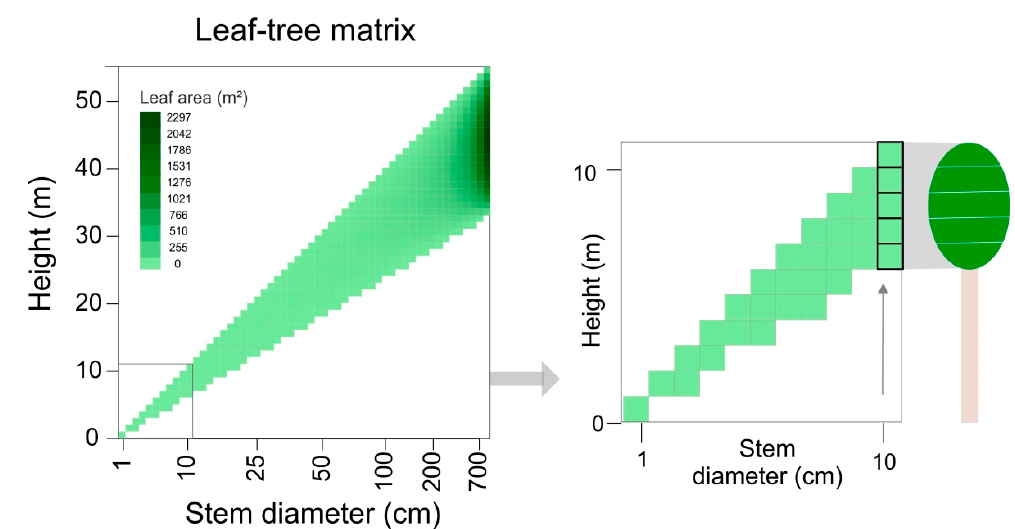
Figure 2. Visualization of the leaf–tree matrix (left) and an enlarged cut-out (right). Each column in the matrix reflects the leaf area contribution of one tree to different height layers. Columns represent different stem diameter classes. Colors in the matrix show leaf area values with a gradient from light green (low values) to dark green (high values) (white indicating no leaf area). On the right, an exemplary tree of 10 cm stem diameter is highlighted in the cut-out with its crown leaf area distributed to four height layers. Note the logarithmic x-axis of the stem diameter (cm). We denote the leaf–tree matrix by F = ( f ij ) with i , j = 1,…,n and the number of trees for